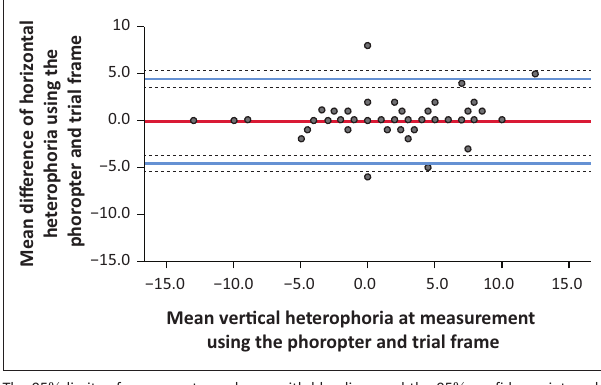
Mean horizontal heterophoria at far The red solid line represents the mean difference. The 95 % limits of agreement are shown in blue solid lines, whilst the 95 % confidence intervals about the limits are represented by dashed lines. Units are in prism dioptres. Thin grey lines at −2 and 2 represent acceptable or good agreement, that is, ± 2 Δ about zero difference; most but not all differences were within ± 2 Δ and the same applies to the 95 % limits of agreement. b FIGURE 7: Bland-Altman plot showing the mean difference (red line) between the horizontal heterophoria measured for distance vision (6 m) using the phoropter and trial frame.